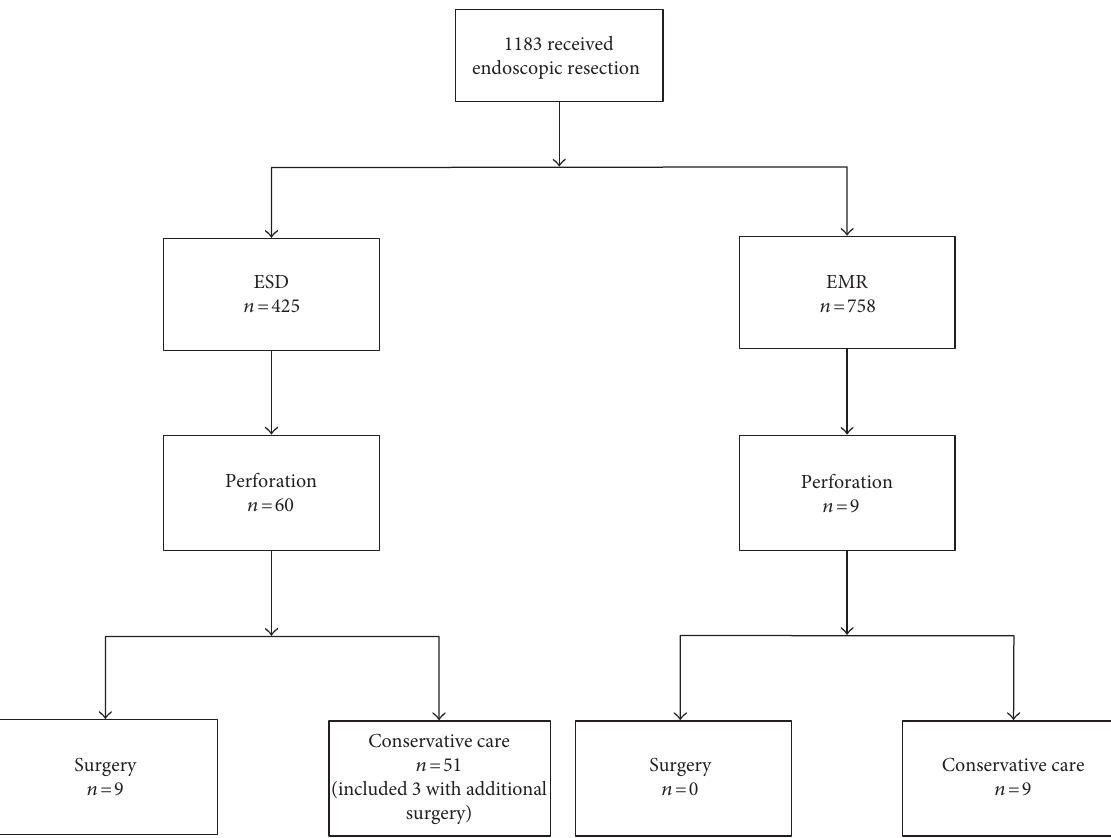
Figure 2: Patient selection and the clinical course of patients after gastric perforation caused by endoscopic resection. EMR, endoscopic mucosal resection; ESD, endoscopic submucosal